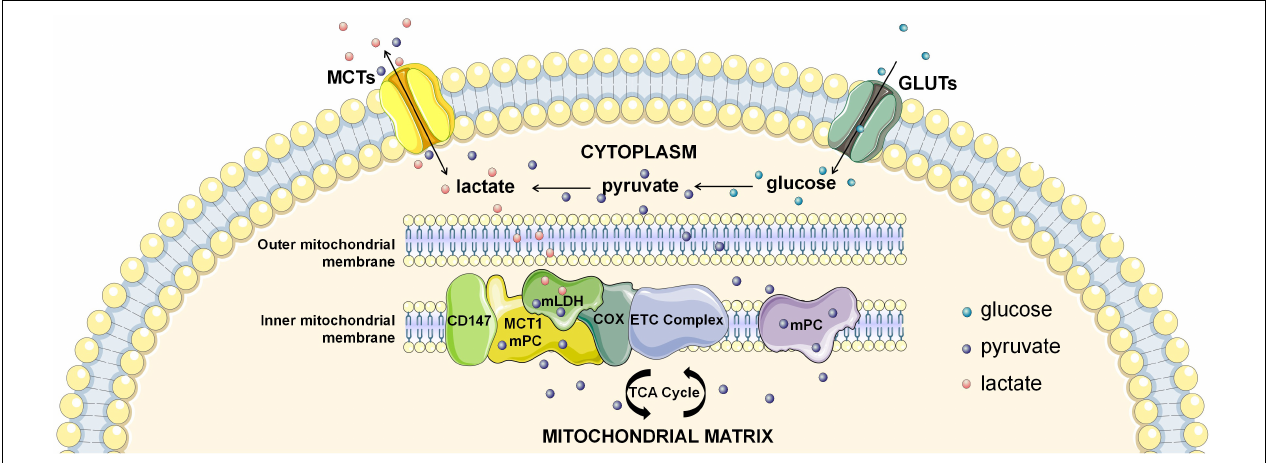
FIGURE 1 | The intracellular lactate shuttle. Both extracellular uptake and glycolytic production make up the cytosolic lactate pool. Intracellular lactate is shuttled from the cytoplasm to mitochondria for subsequent oxidization, facilitated by the mitochondrial lactate oxidation complex (mLOC). Monocarboxylate transporter 1 (MCT1) is inserted into the inner mitochondrial membrane, and CD147 is an indispensable chaperone protein of MCT1. Mitochondrial LDH (mLDH) is distributed on the surface of the inner mitochondrial membrane, and oxidizes lactate to pyruvate. In addition, terminal electron transport chain element cytochrome oxidase (COX) is responsible for the endergonic lactate oxidation. Mitochondrial pyruvate carrier (mPC) is distributed in the inner mitochondrial membrane, which is responsible for the mitochondrial transmembrane transport of